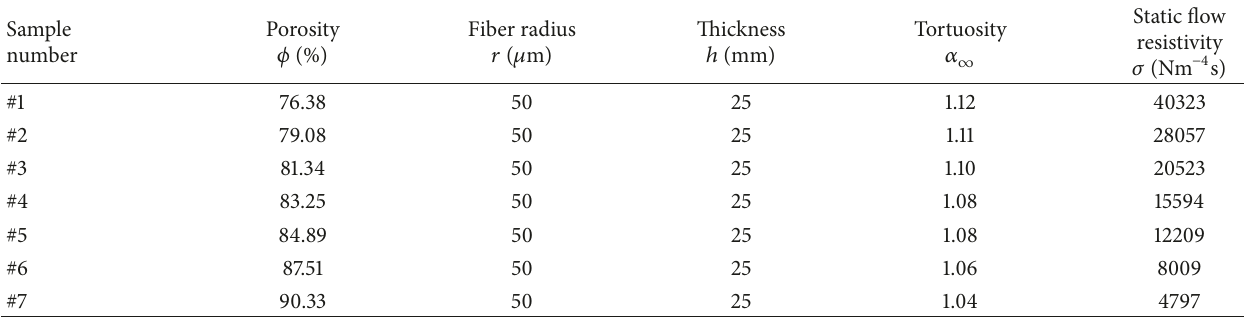
Table 6: The physical parameters of the porous metallic samples and calculated static flow resistivities.